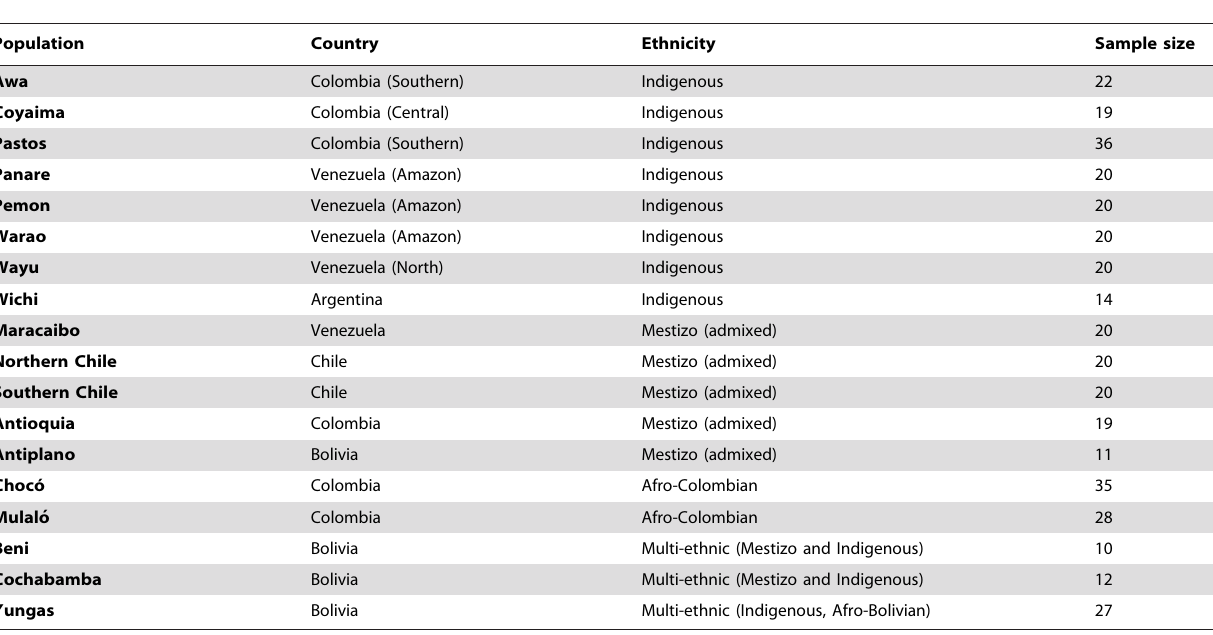
Table 7. Latin American populations genotyped in stage III of this study.